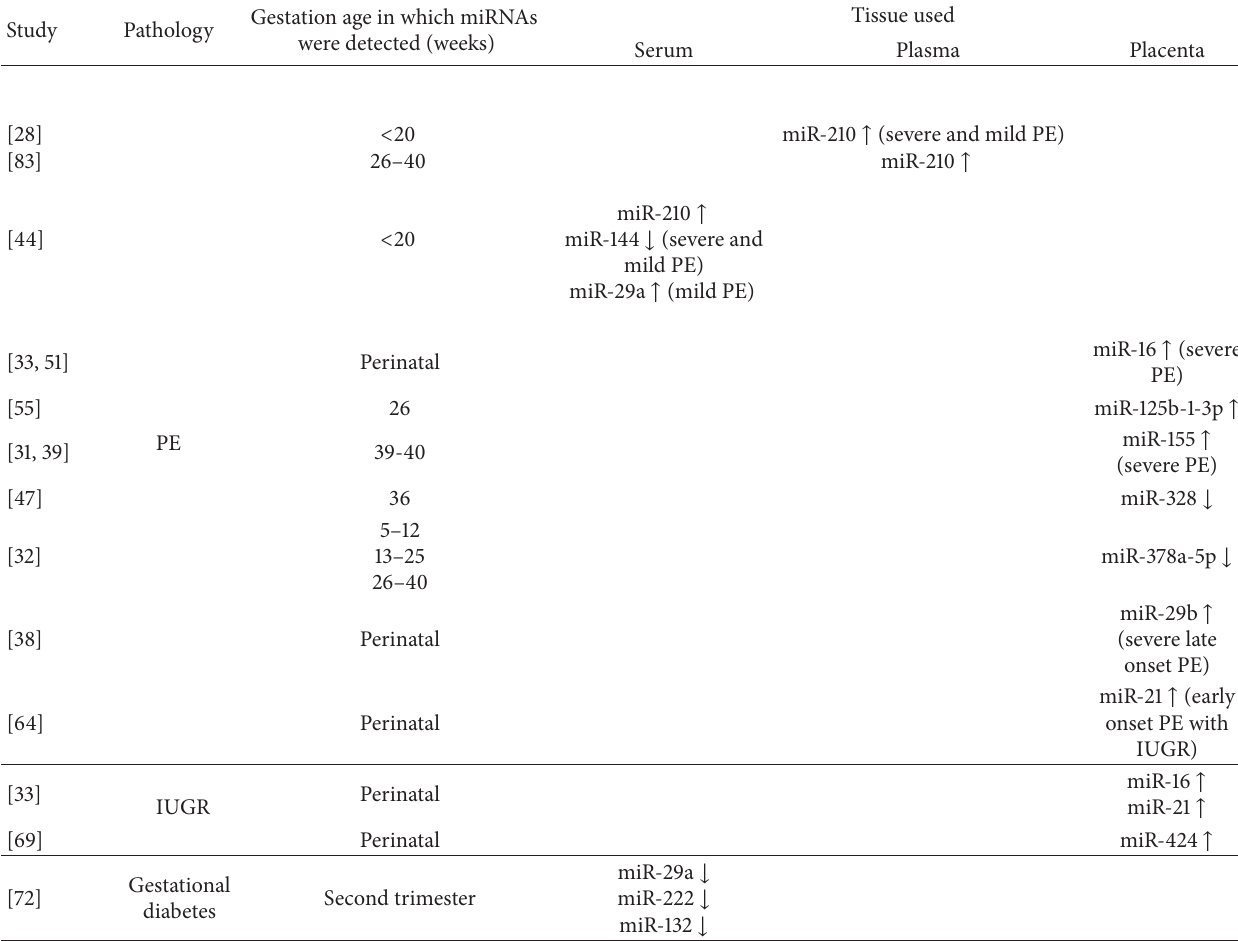
Table 1: AngiomiRs detected in pregnancy’s vascular